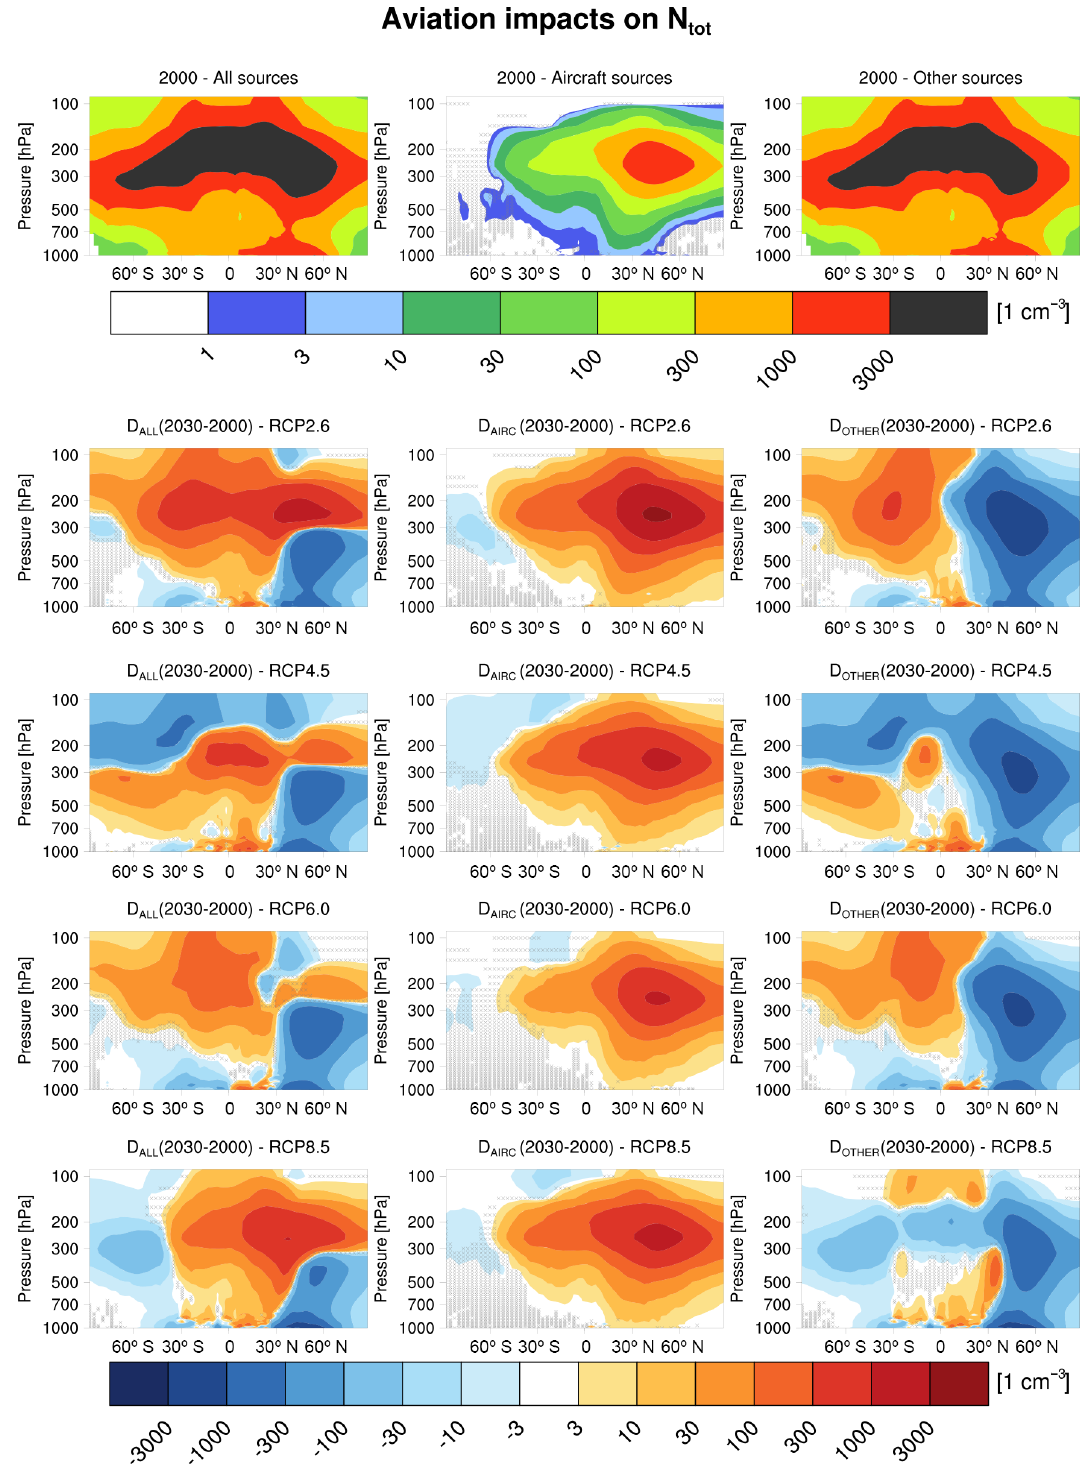
Figure 6. As in Fig. 3 but for fine particle ( (cid:46) 1µm, sum of the Aitken- and accumulation-mode particles) number concentrations.